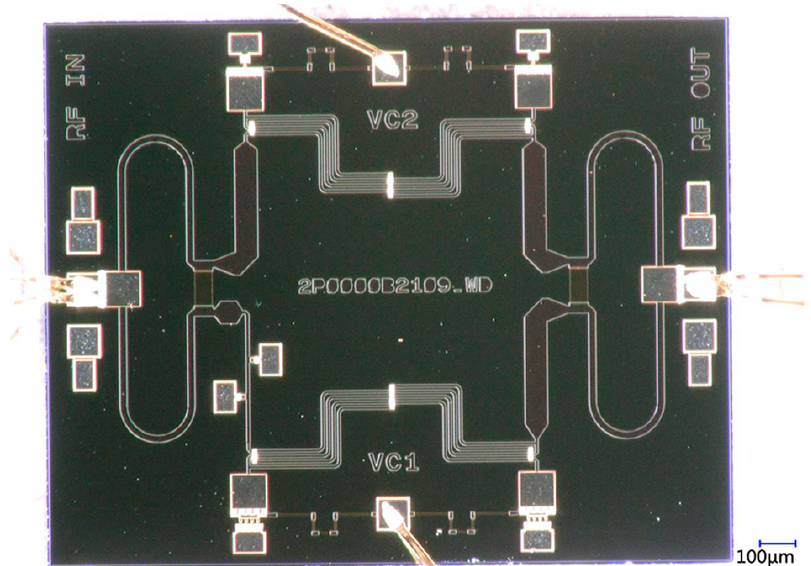
Figure 7. APD MMIC Photo.